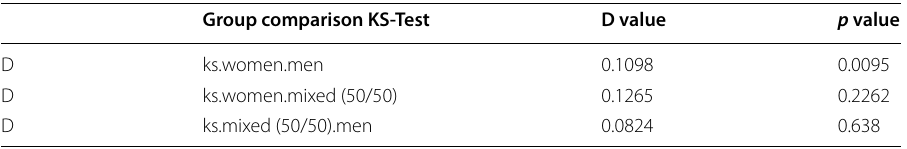
Table 10 Pairwise group comparisons (Kolmogorow–Smirnow-test) for skewness degree of gendered communities for second